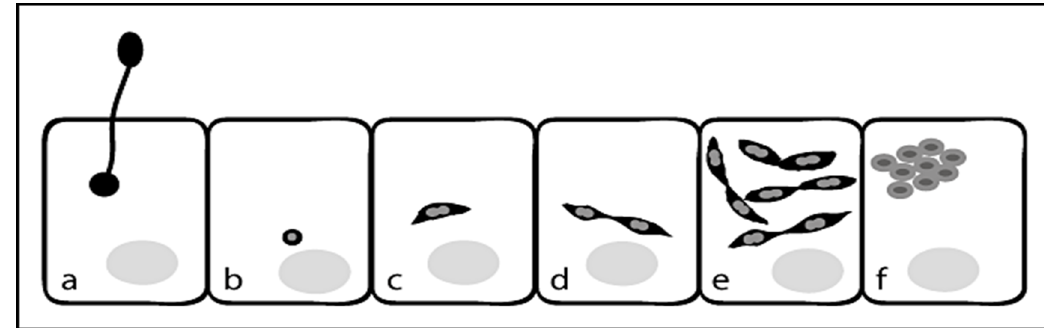
Figure 2. Pathogenesis and transmission of N. ceranae into a host cell. Schematic representation of the early events in the life cycle of N. ceranae : ( a ) injection of the sporoplasm into the host cell, ( b ) the sporoplasm in the host cell, ( c ) aspindle-shaped meront, ( d ) paired meronts, ( e ) several rounds of cell division, ( f ) round to oval sporonts.